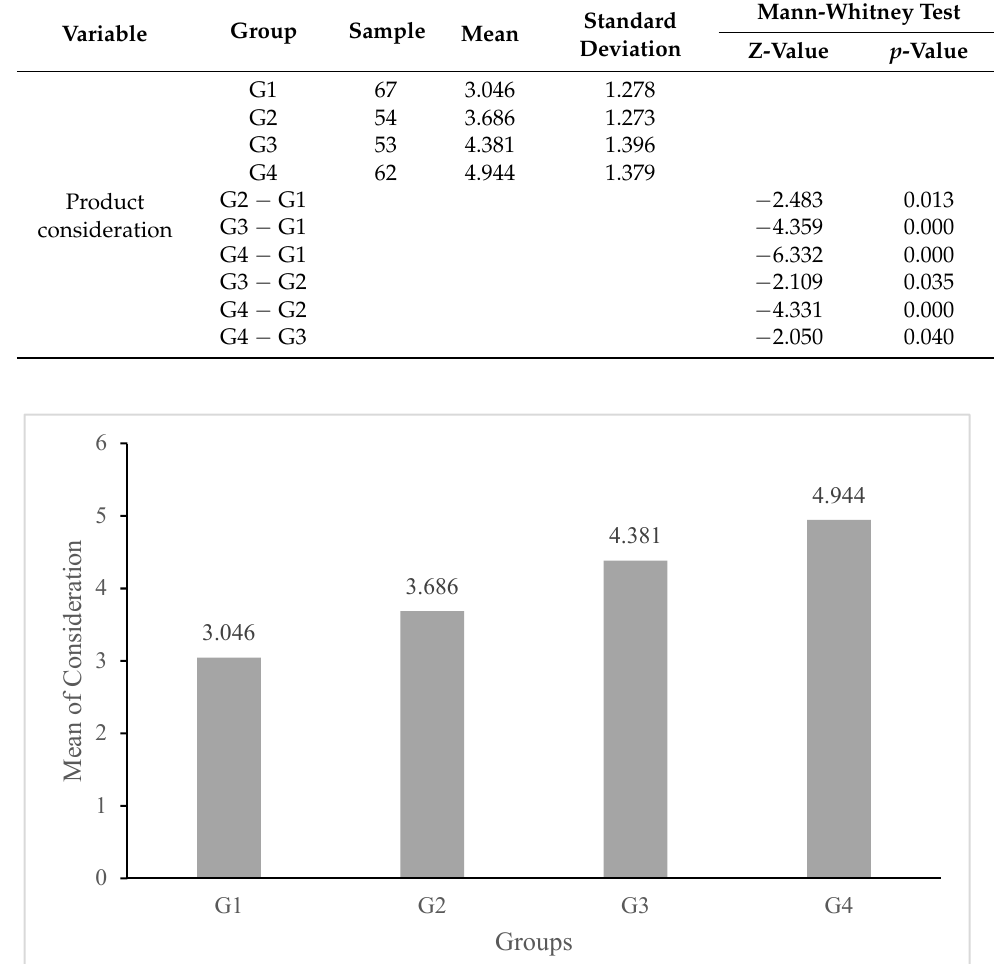
Table 8. Difference test of product consideration under different groups.